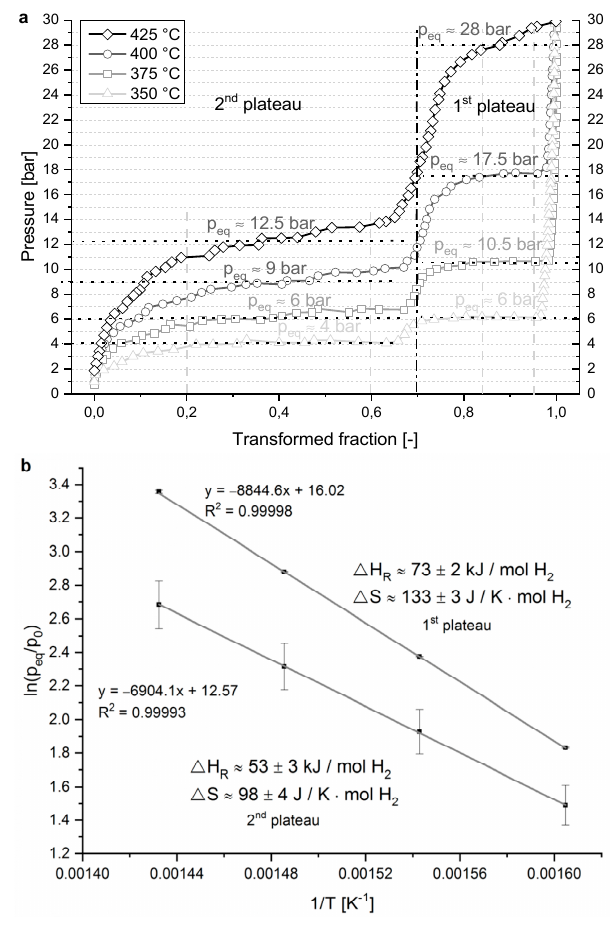
Figure 1. Pressure concentration isotherms under dehydrogenation conditions at 425 °C, 400 °C, 375 °C, and 350 °C ( a ) and ( b ) the resulting van’t Hoff plot for the first and for the second plateaus.